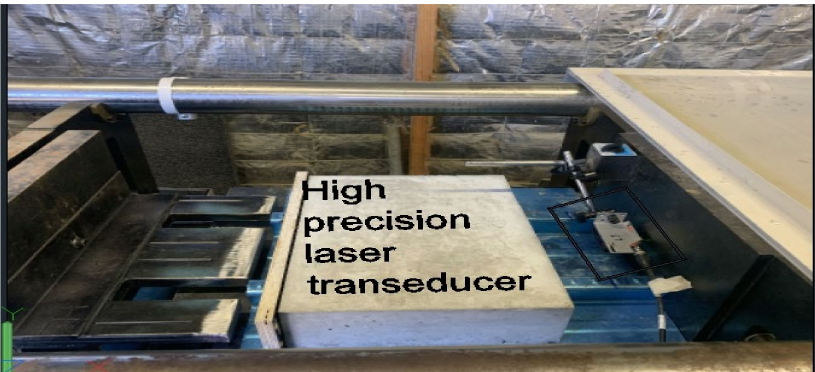
Figure 14. High precision laser sensor.